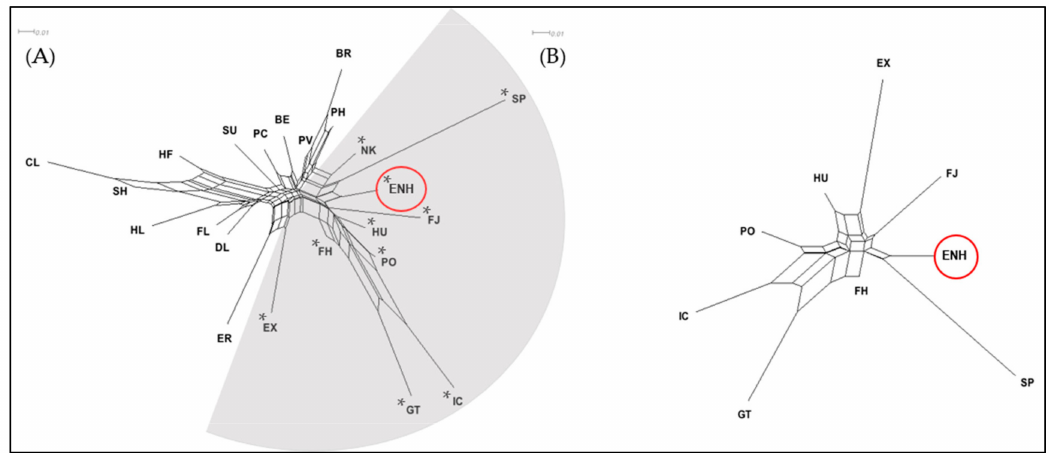
Figure 2. Neighbor-network trees based on Reynolds genetic distance of 23 horse breeds. ( A ) Distance mapping of the ENH (circled) and 22 breeds created two subpopulations; breeds indicated with asterisks (*) in the grey-shaded area belong to Group A in Figure 1. ( B ) Distance mapping of the ENH (circled) with 8 related breeds. Branch length indicates population divergence. Breed abbreviations are the same as in Figure